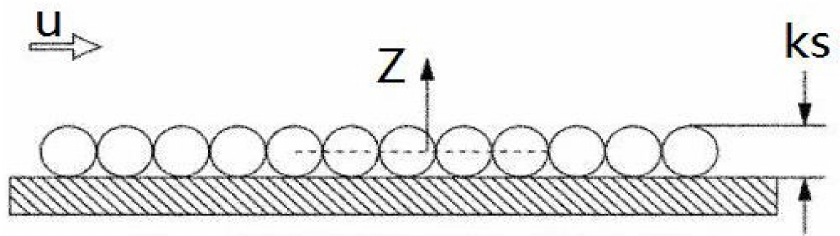
Figure 6. Schematic diagram of equivalent gravel